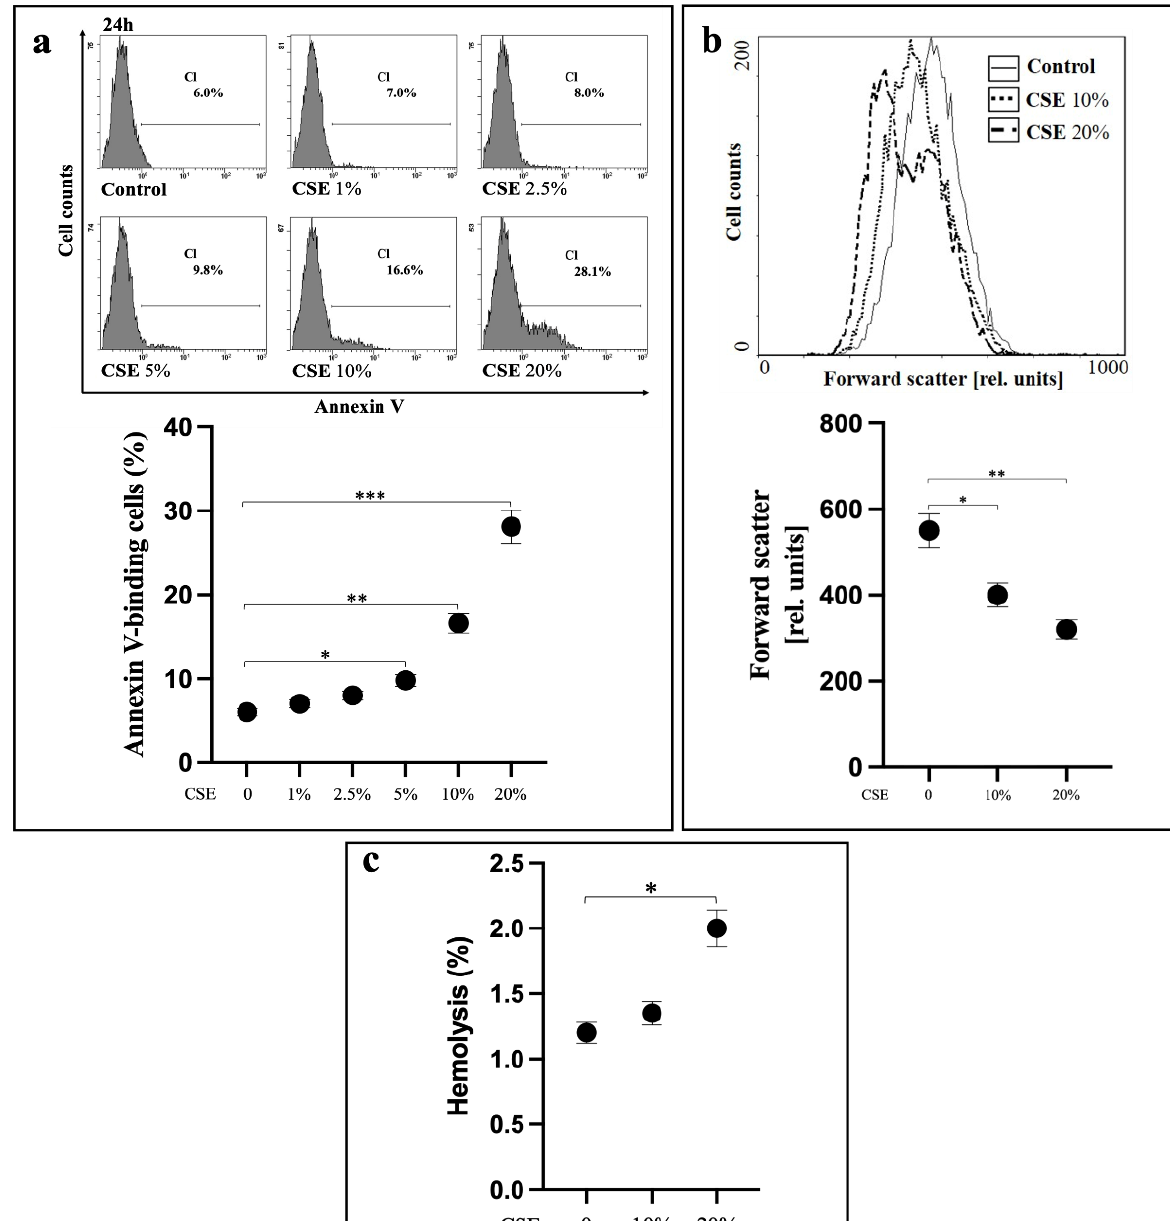
Figure 1. CSE induces eryptosis. ( a ) Percentage of PS-exposing erythrocytes, ( b ) their FSC and ( c ) percentage of cell haemolysis after 24 h incubation with CSE. RBCs incubated with vehicle were used as control. Values are means ± SD of six independent experiments carried out in triplicate. * p < 0.05; ** p < 0.01; *** p < 0.001 (ANOVA associated with Tukey’s test).